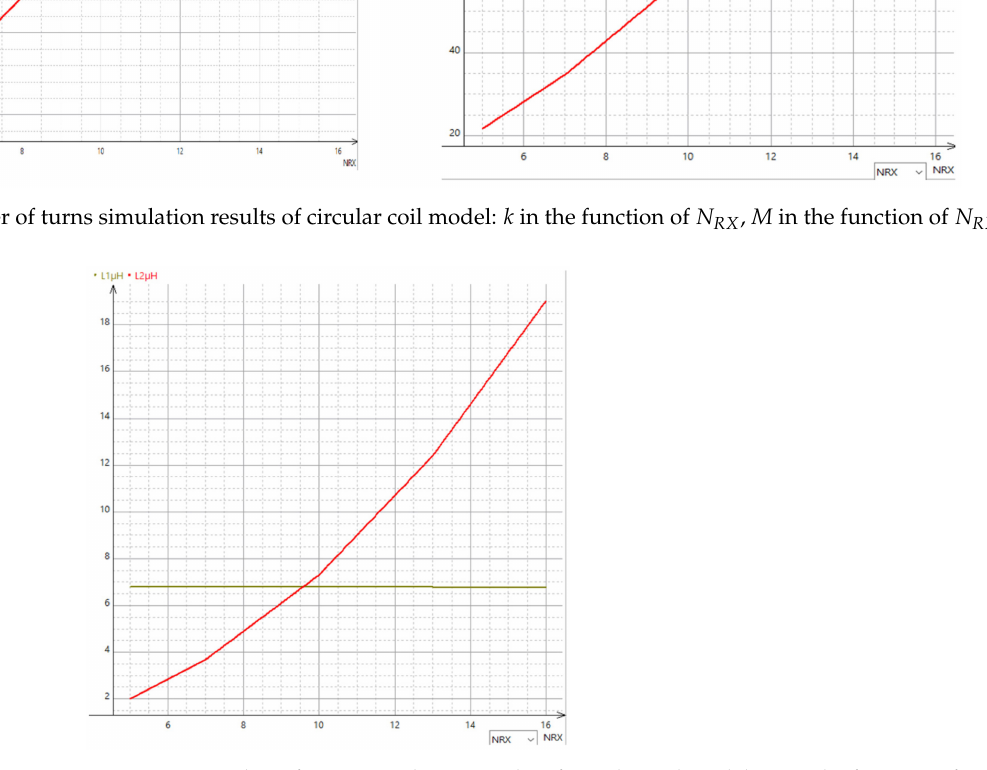
Figure 19. Number of turns simulation results of circular coil model: L 1 in the function of N RX , L 2 in the function of N RX